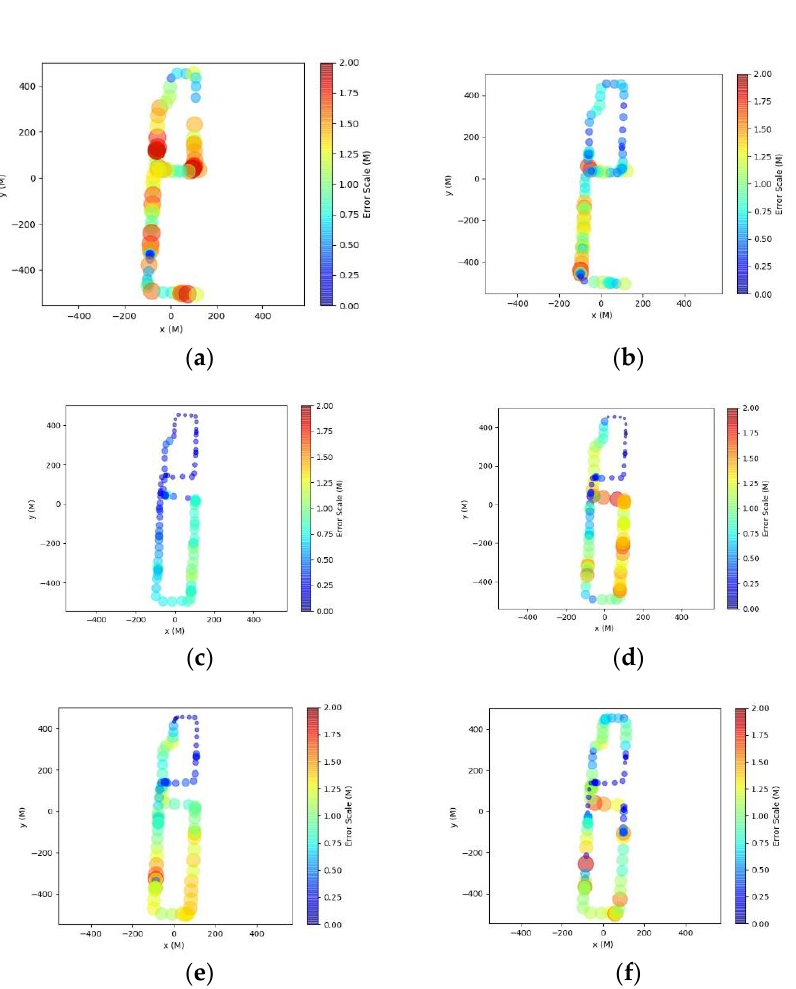
Figure 6. Color maps of accuracy assessment for 5 s slice length (marker size and color indicate error magnitude): ( a ) InvenSense; ( b ) Epson_1; ( c ) Honeywell_1; ( d ) Epson_2; ( e ) Honeywell_2; ( f ) Epson_3. Note that the coordinates have been reduced to a local system for display clarity.